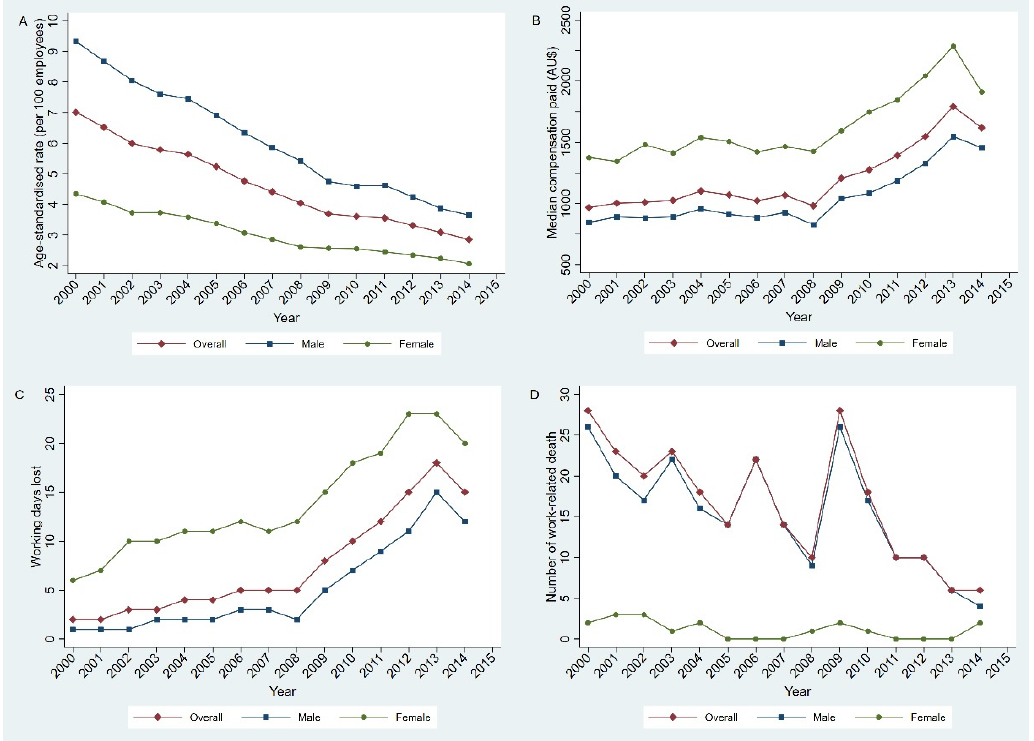
Figure 1. Trends in workers’ compensation claim statistics in South Australia, 2000–2014: ( A ) age- standardised claim rates, ( B ) median compensation payments, ( C ) interquartile range of working days lost, and ( D ) the number of work-related deaths.